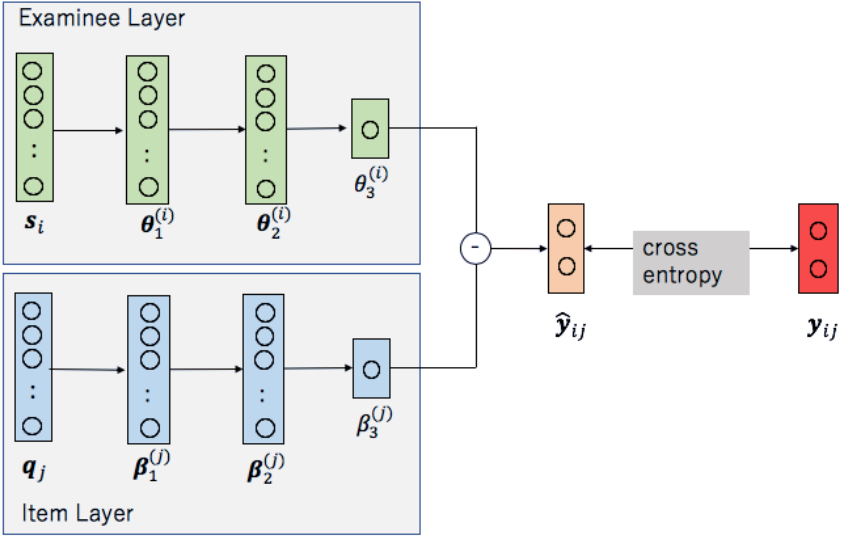
Figure 1. Outline of